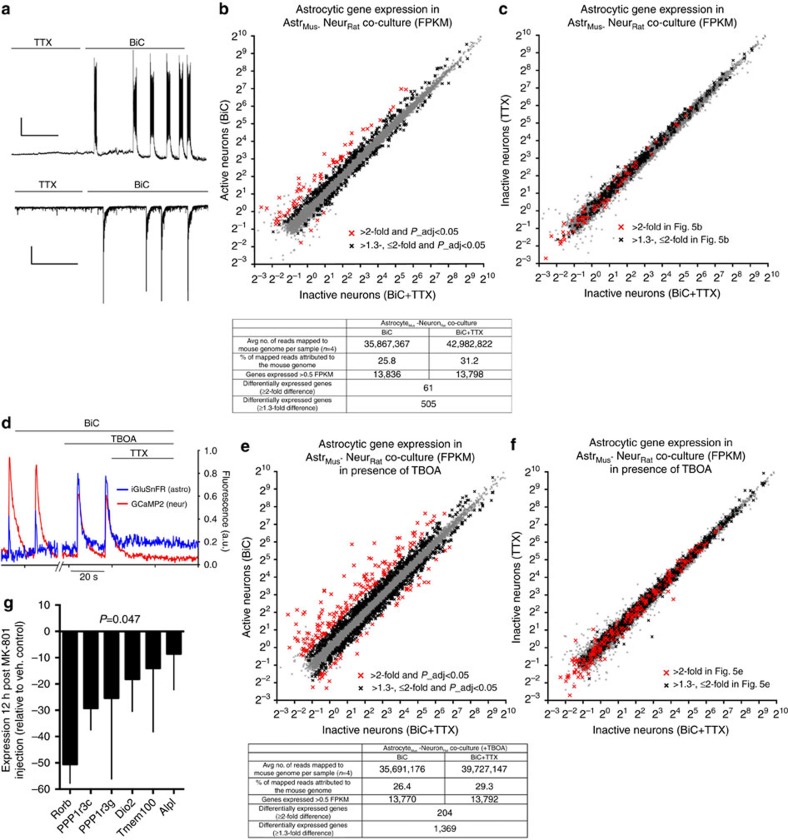
Synaptic activity regulates astrocytic gene expression.(a) Mixed-species astrocyte–neuron co-cultures were transferred into TTX-containing medium for 22 h, after which it was washed out in the presence of BiC. Whole-cell current-clamp (upper) and voltage-clamp (lower) recording of the resultant burst activity. Scale bar, 15 mV, 30 s (upper); 50 pA, 30 s (lower). (b) Mixed-species co-cultures were treated as in a, or a control that was ‘washed’ but remained in TTX (BiC+TTX), and RNA extracted at 16 h post-wash. SSS RNA-seq identified mouse (that is, astrocyte) reads. Expression of genes (FPKM) in astrocytes±neuronal synaptic activity is plotted for the genes expressed >0.5 FPKM averaged over the conditions. Red and black crosses indicate the astrocytic genes changed by neurons more than twofold or >1.3, ≤2-fold respectively (DESeq2 P_adj<0.05, n=4 biological replicates). See Supplementary Data 10. (c) To confirm that BiC was not having a direct effect on astrocytic gene expression independent of AP firing, gene expression in the (BiC+TTX) condition was compared to a condition where the neurons remained in TTX. The crosses indicate those genes significantly changed in b. (d) Example trace depicting an astrocyte–neuron co-culture in which astrocytes had been transfected with iGluSnFR68 before neuronal co-culture, after which neurons were transfected with GCaMP2. GCaMP2-positive neurons and iGluSnFR-positive astrocytes were imaged concurrently in the presence where indicated of BiC (50 μM), TBOA (50 μM) and TTX. (e) Impairing glutamate re-uptake enhances activity-dependent astrocytic gene regulation. Experiment performed exactly as in b except co-cultures were treated with TBOA (50 μM) at the time of BiC addition (n=4). See Supplementary Data 11. (f) To confirm that BiC+TBOA were not having a direct effect on astrocytic gene expression, expression in the (BiC+TBOA+TTX) condition was compared to a further condition where the neurons remained in TTX. The crosses indicate those genes significantly changed in e. (g) P7 mice were treated with MK-801 (0.5 mg kg−1) or PBS and cortical expression of the indicated astrocyte-specific, activity-regulated genes analysed 12 h post-injection. *P<0.05 (2-way analysis of variance, Con versus MK-801; n=8 con, 8 MK), P value indicates the main effect of drug treatment versus PBS. Error bars represent s.e.m.